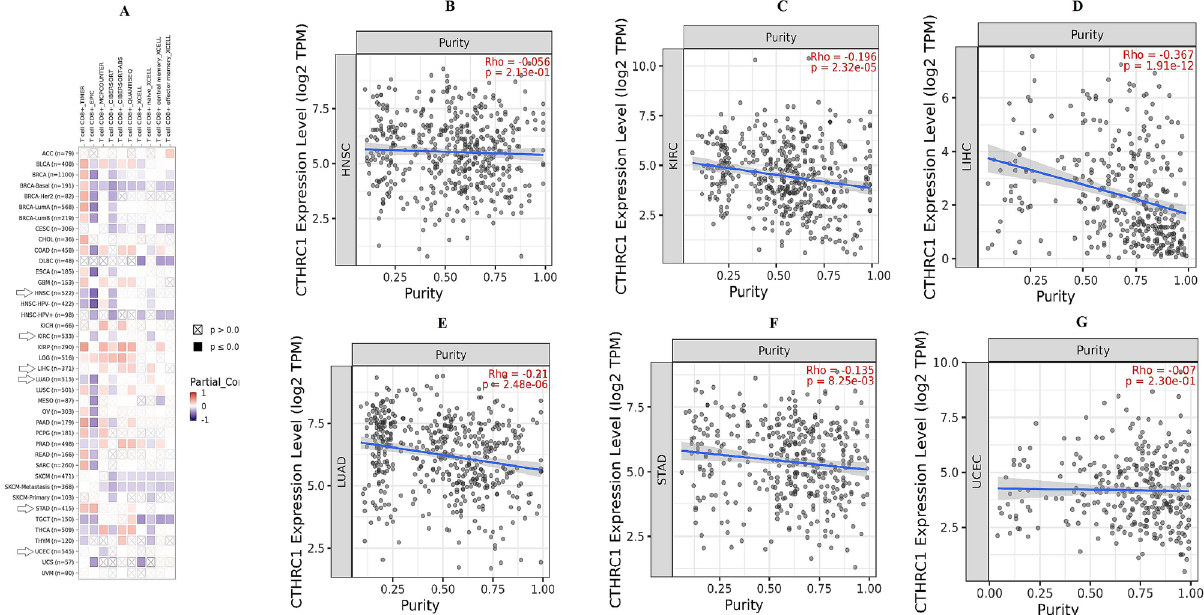
Figure 15. TIMER based Spearman correlational analysis between CTHRC1 expression and CD8+ T immune infiltration and tumor purity in HNSC, KIRC, LIHC, LUAD, STAD, and UCEC. ( A ) A correlation analysis between CTHRC1 expression and CD8+ T immune infiltration in HNSC, KIRC, LIHC, LUAD, STAD, and UCEC, ( B ) a correlation analysis between CTHRC1 expression and tumor purity in HNSC, ( C ) a correlation analysis between CTHRC1 expression and tumor purity in KIRC, ( D ) a correlation analysis between CTHRC1 expression and tumor purity in LIHC, ( E ) a correlation analysis between CTHRC1 expression and tumor purity in LUAD, ( F ) a correlation analysis between CTHRC1 expression and tumor purity in STAD, and ( G ) a correlation analysis between CTHRC1 expression and tumor purity in